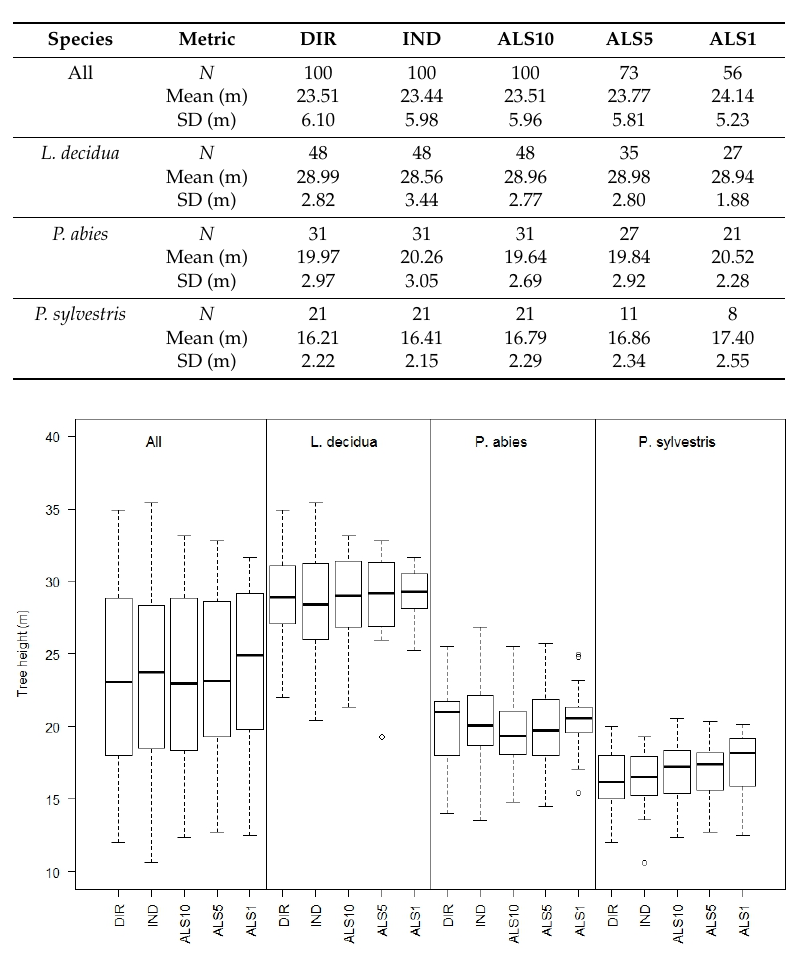
Table 3. Average (Mean) and standard deviation (SD) values of tree heights measured by three estimation methods: field direct (DIR), indirect (IND), and Airborne Laser Scanning (ALS) for the whole dataset (All) and divided by species. ALS data are presented divided by pulse densities (10, 5, 1 points/m 2 ) obtained through point cloud thinning. N indicates the total of detected trees by ALS from the original dataset of felled trees.